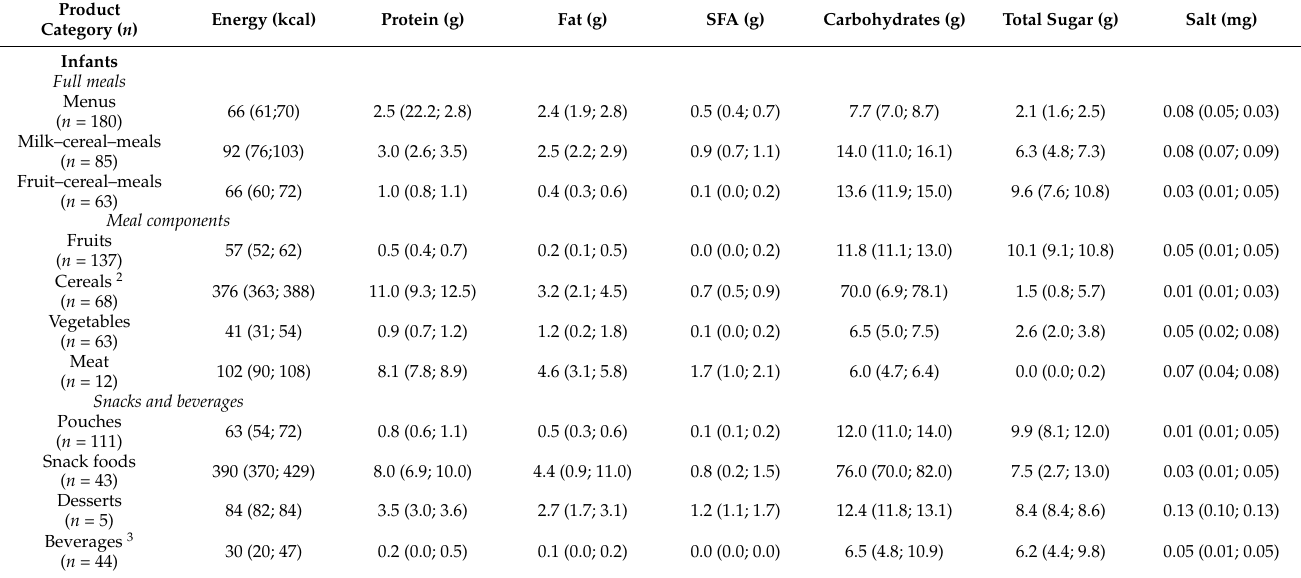
Table 2. Declared energy and nutrient contents per 100 g of commercial complementary food products for infants and toddlers, results of a 2020 market survey in Germany (values are medians (quartile 1, quartile 3) 1